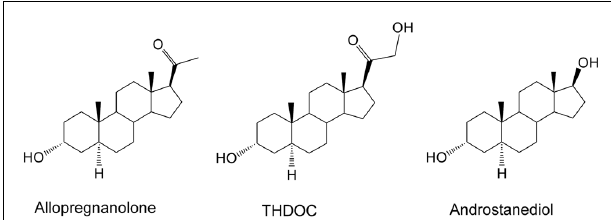
FIGURE 1 | Chemical structures of major endogenous neurosteroids. THDOC differs from allopregnanolone by a 21 β -hydroxyl group, while androstanediol differs from allopregnanolone by a 17 β -hydroxyl group instead of 17 β -methyl-carbonyl group. Synthetic analogs of neurosteroids are prepared by additional moieties at C3-position (e.g., ganaxolone), C2- and C11-positions (alphaxolone), and C11-position (minaxolone).